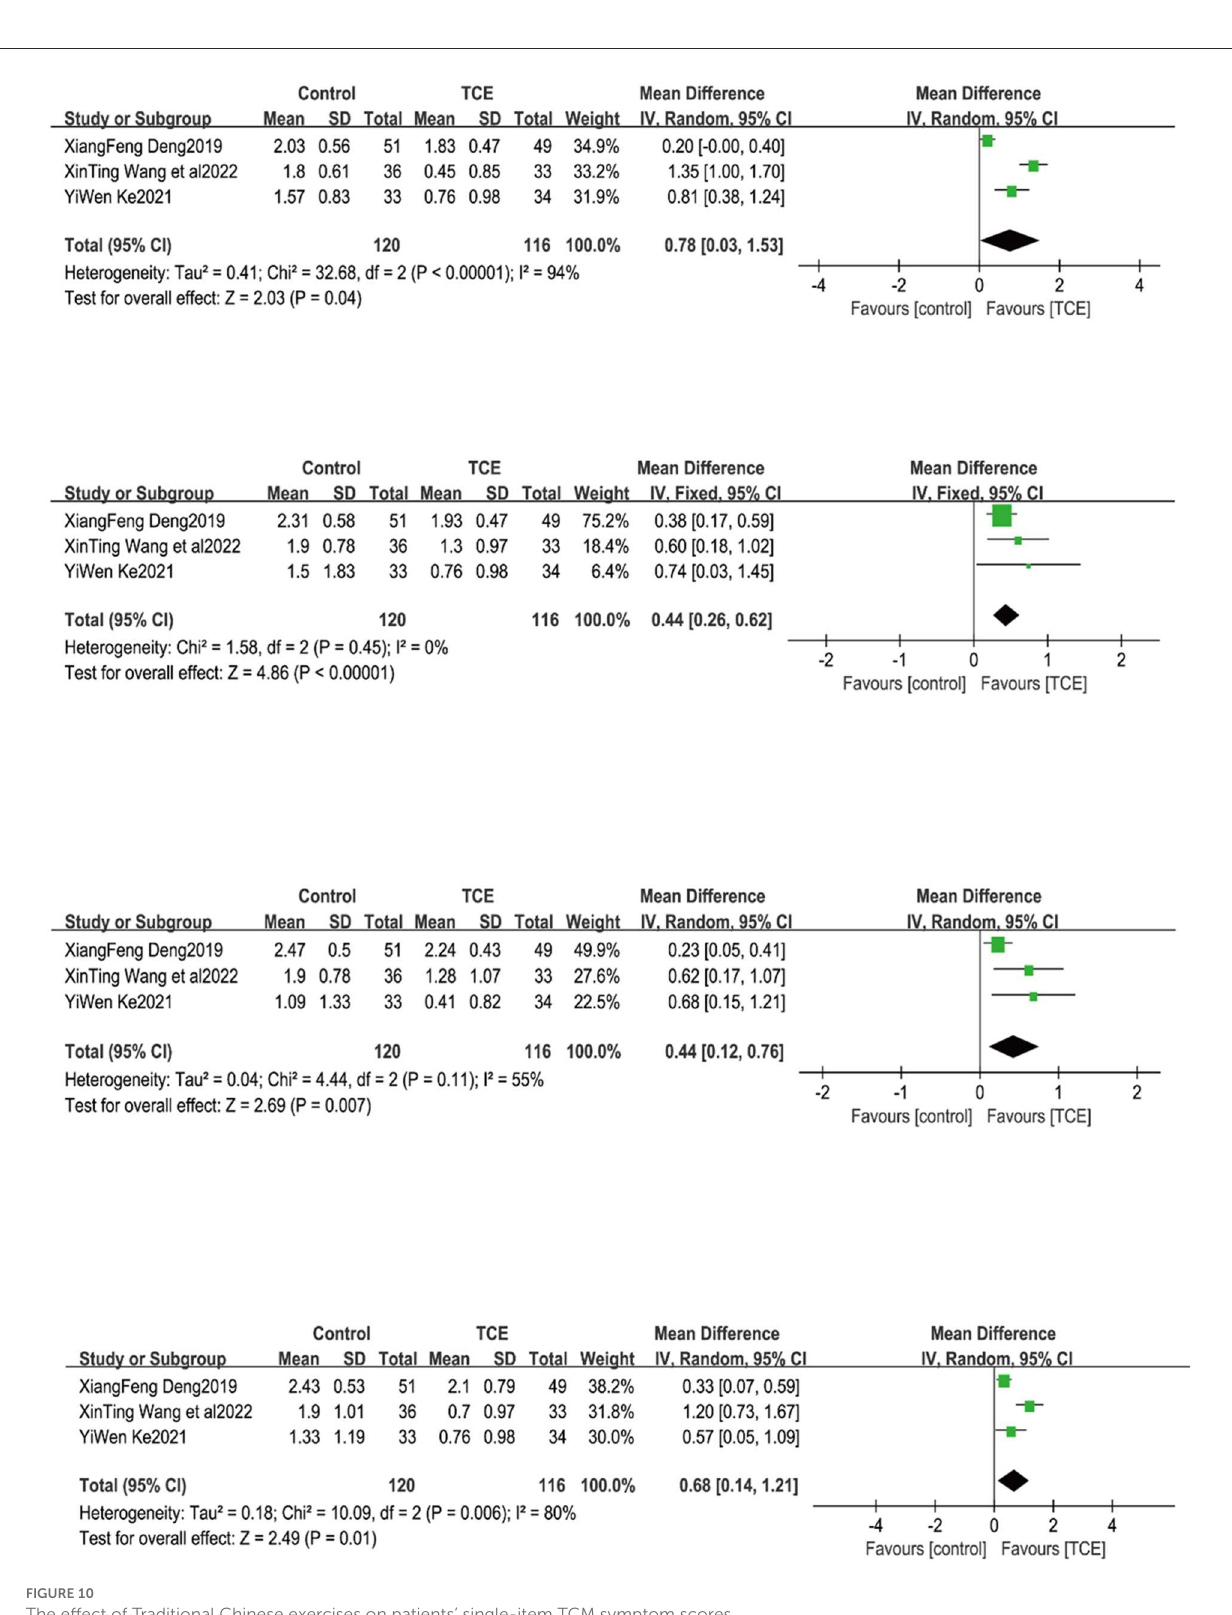
FIGURE10 The effect of Traditional Chinese exercises on patients’ single-item TCM symptom